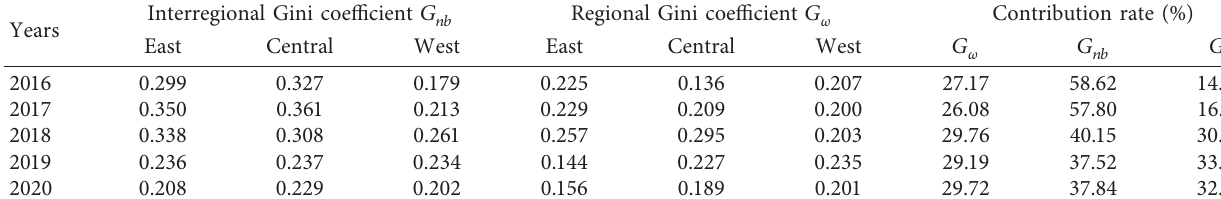
Table 5: Dagum Gini coefficient and its decomposition results.